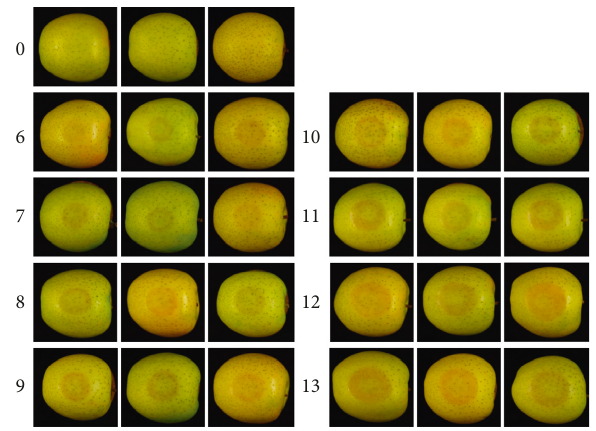
Figure 1: Apple photographs used in the questionnaire. Note . The numbers to the left of each photograph stand for the severity of the damage estimated by area ( × 10 − 4 m 2